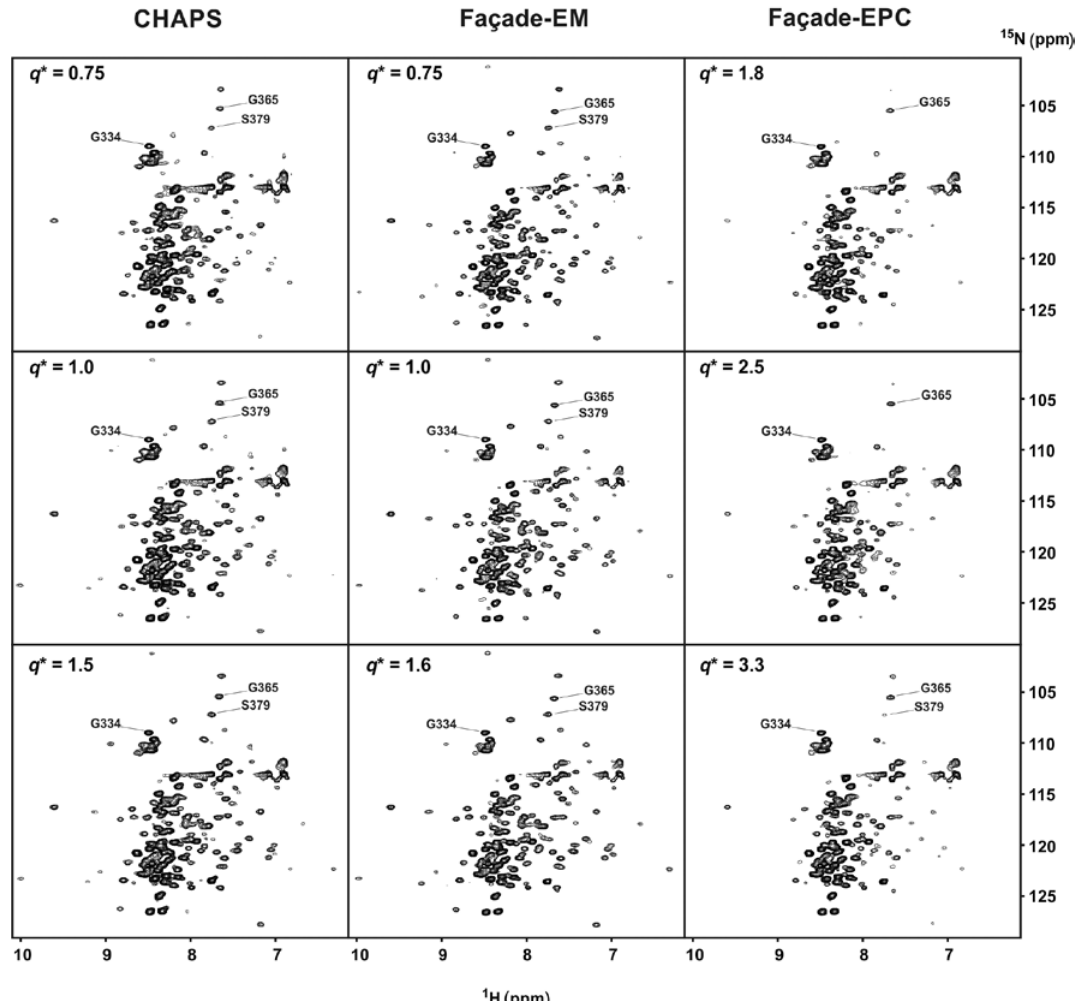
Figure 4: 1 H, 15 N-TROSY spectra of p75- Δ ECD in DMPC/CHAPS (left column), DMPC/Façade-EM (middle column), and DMPC/Façade-EPC (right column) at various q * . All spectra were recorded at 20 ° C, pH 7.0 and were processed and visualized identically. Signals that were used to assess the quality of the spectrum of p75NTR DD are